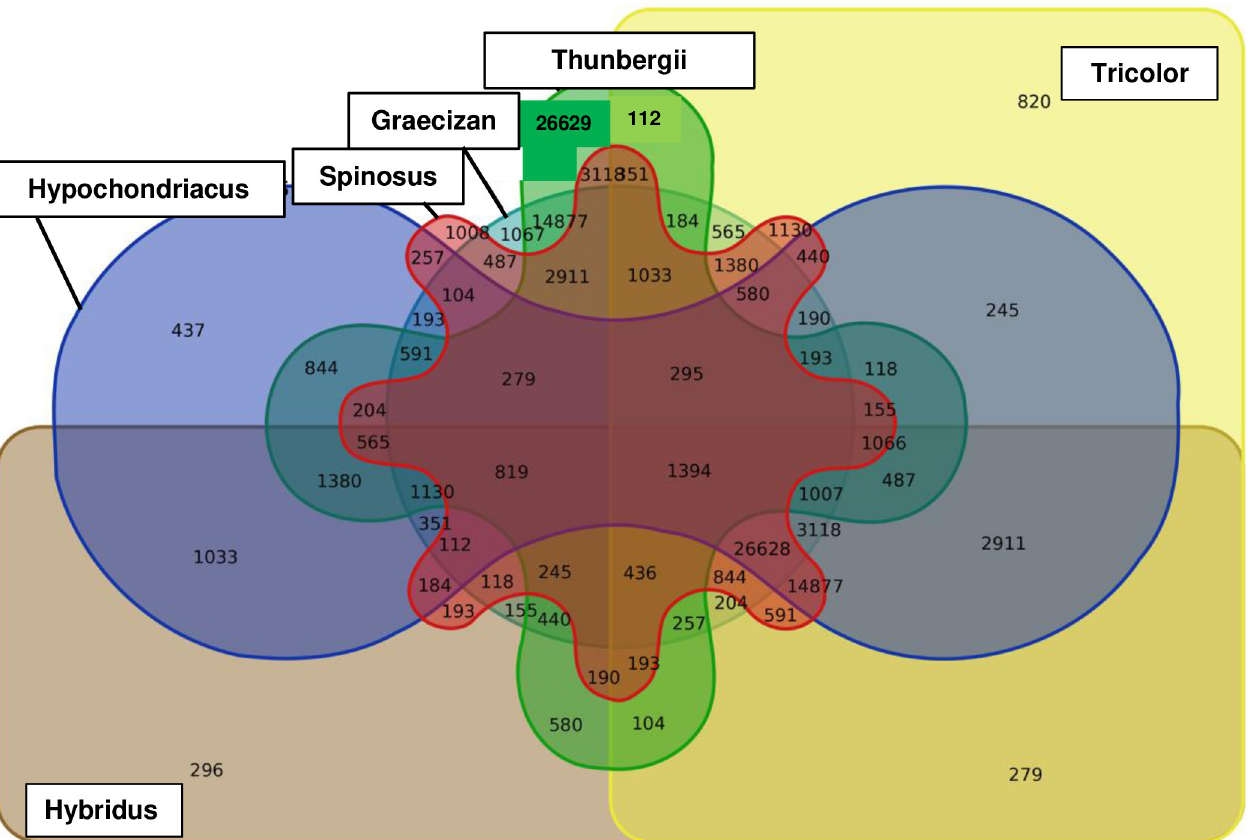
Fig 1. Venn diagram showing the presence, average and overlap of SNPs in the six largest amaranth species sets.